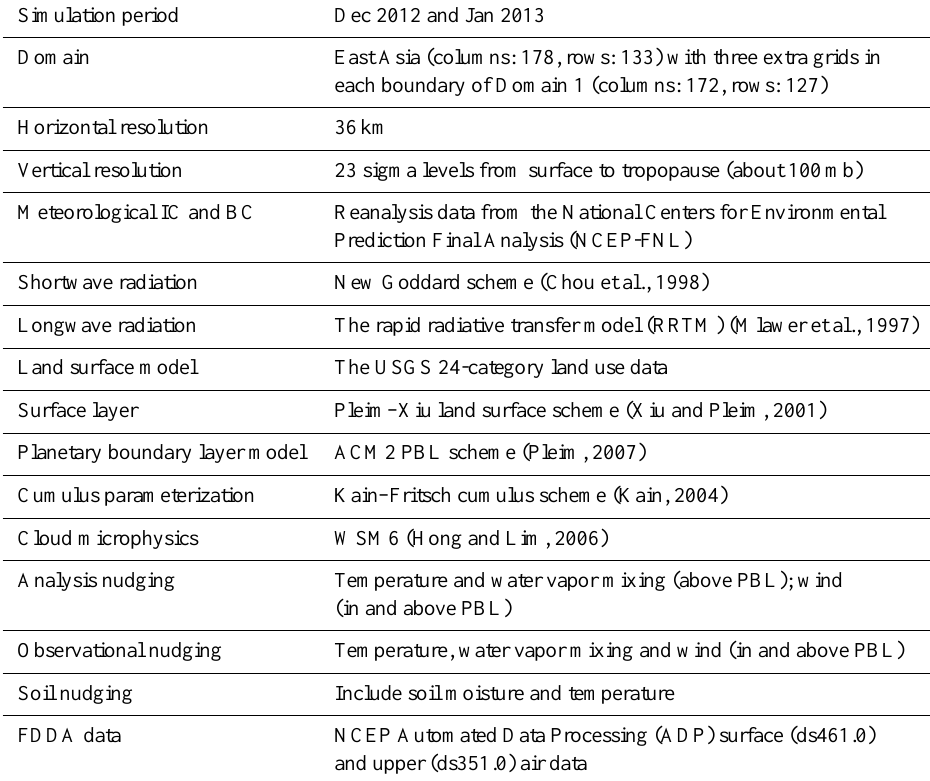
Table 2. Domain, configurations and major physical options used in WRF v3.5.1. Simulation period East Asia (columns: 178, rows: 133) with three extra grids in each boundary of Domain 1 (columns: 172, rows: